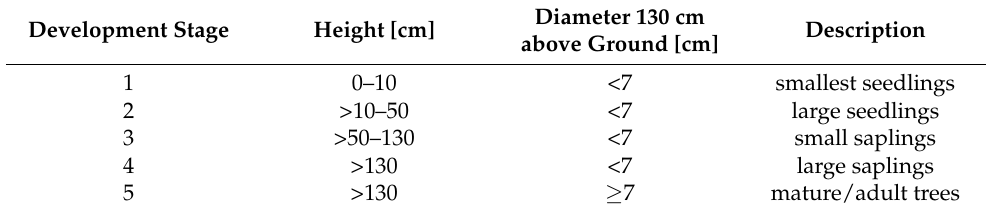
Table 1. Parameters and description of development stage